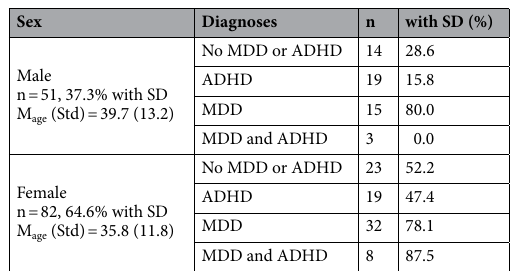
Figure 1. Receiver operating characteristics curve and confusion matrix.